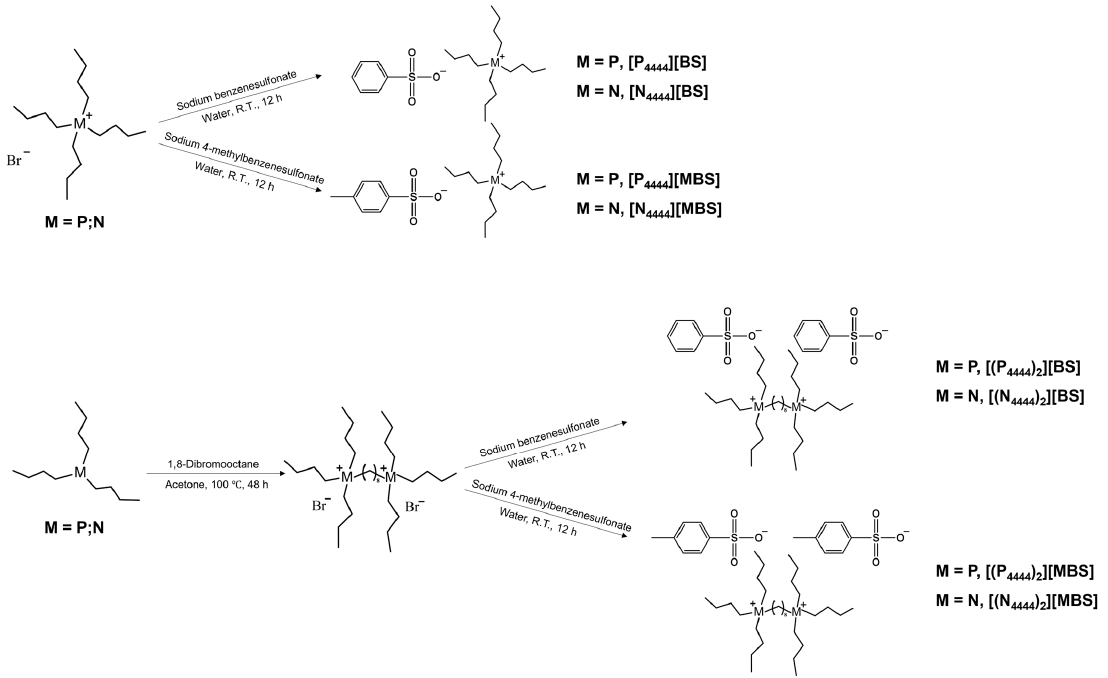
Figure 2. Synthetic route of the monocationic ILs ( top ) and dicationic ILs ( bottom ) used in this study. Structural analysis of the ILs used in this study was performed using 1 H-NMR spec- troscopy. The 1 H-NMR spectra of the monocationic series are shown in Figure 3a–d. In Figure 3a, the spectrum of [P 4444 ][BS] contains peaks from the aromatic group of the ben- zenesulfonate moiety ( δ = 7.48 − 7.68 (peaks g and f) and 7.68 − 7.90 ppm (peak e)) and peaks from alkyl groups of the tetrabutylphosphonium moiety ( δ = 0.69 − 0.89 (peak a), 1.18 − 1.71 (peaks b and c), and 2.08 − 2.14 ppm (peak d)). The 1 H-NMR spectrum of [P 4444